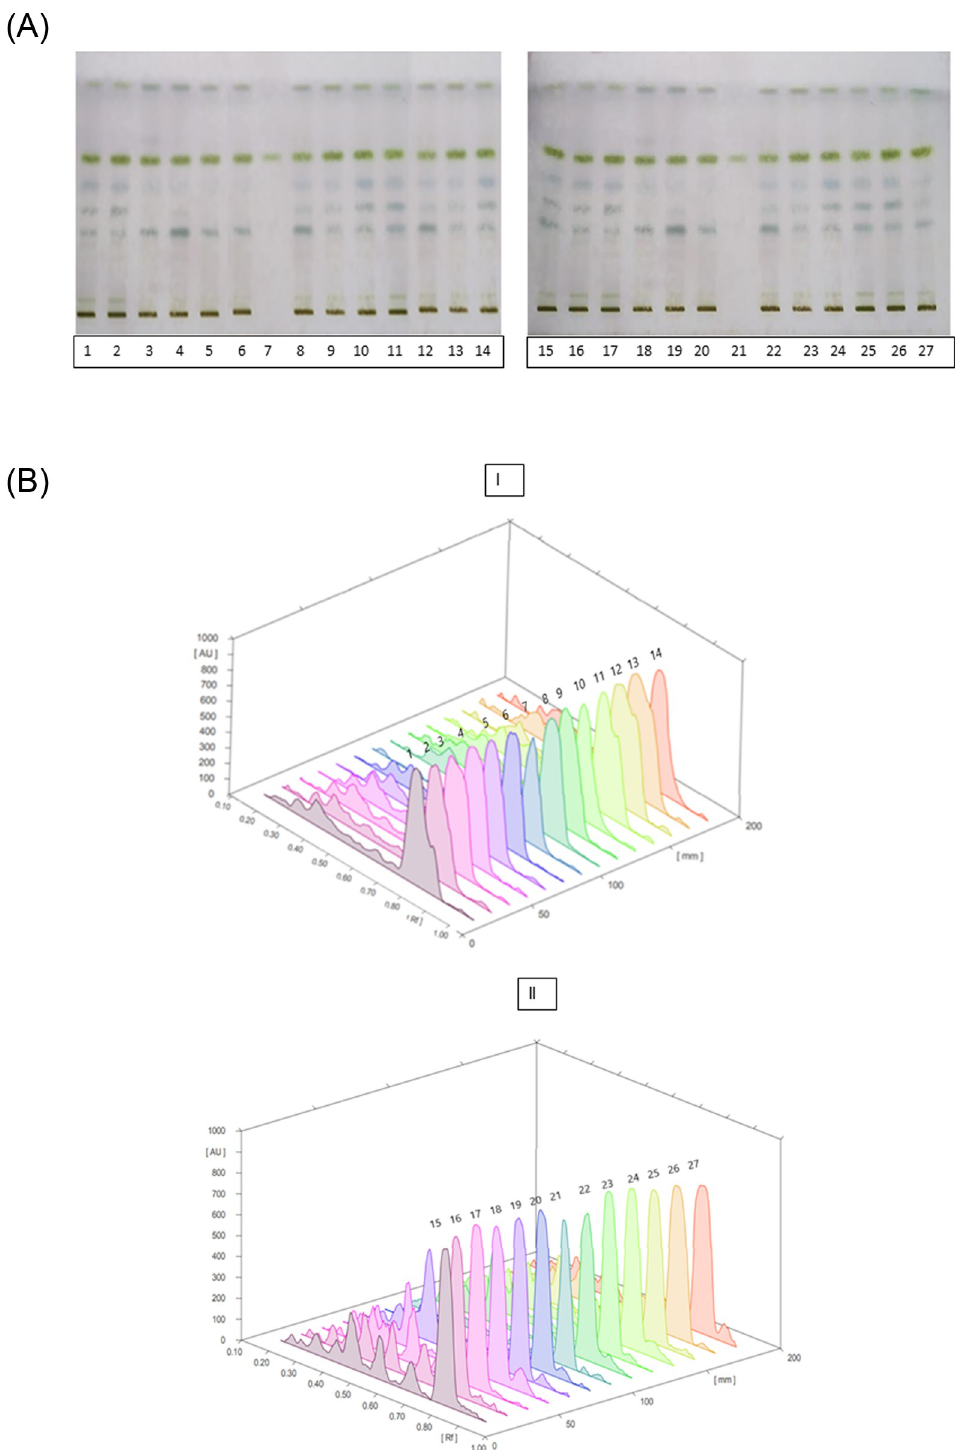
Fig 2. A HPTLC fingerprinting of BBD samples (1–27) after derivatizing by anisaldehyde regent. B Chromatogram I of BBD samples (1–14); Chromatogram II of BBD samples (15–27).